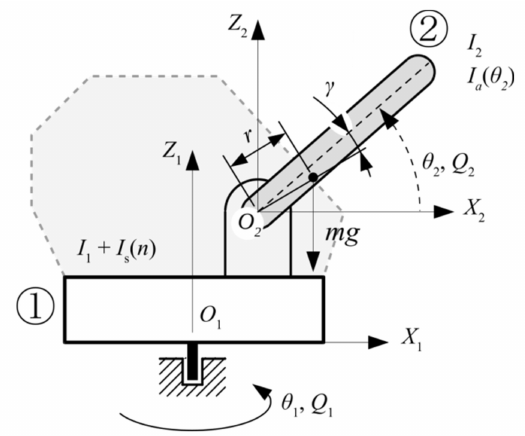
Figure 3. ARS mechanical model schematic diagram. Designations in Figure 3: θ 1 , azimuth angle; θ 2 , elevation angle; Q i , generalized moment acting on i -th element; I 1 , constant mass moment of inertia of body (1) in relation to Z 1 axis; I s ( n ), variable mass moment of inertia of body (1) in relation to Z 1 axis depending on the amount of cartridges n in boxes; I 2 , constant mass moment of inertia of body (2) in relation to y 2 axis; I a ( θ 2 ), variable mass moment of inertia of body (2) in relation to z 1 axis depending on elevation angle θ 2 ; m , mass of body (2); g , gravitational acceleration; r , distance between the center of gravity of body (2) and y 2 rotation axis; γ , angular displacement of the center of gravity of body (2) with regard to the axis of a gun